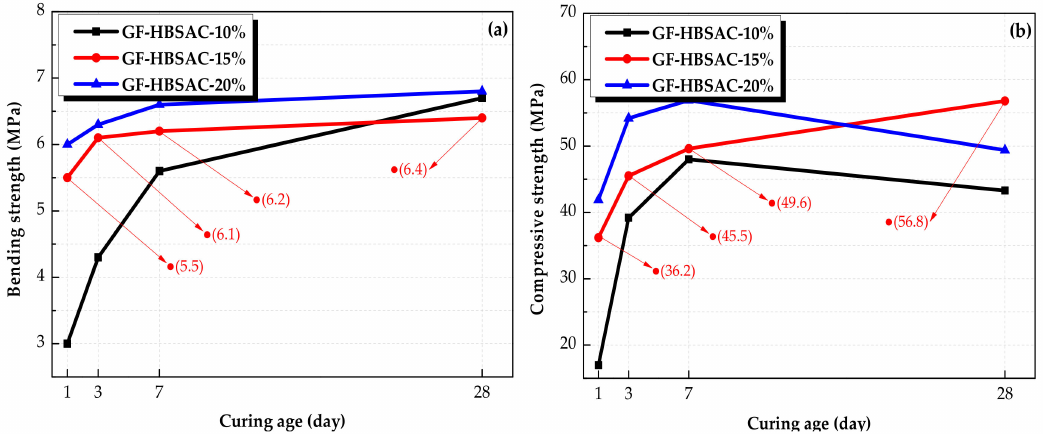
Figure 21. Mechanical strength of the Series GF-HBSAC-Y cement at di ff erent curing ages: ( a ) Bending strength; ( b ) compressive